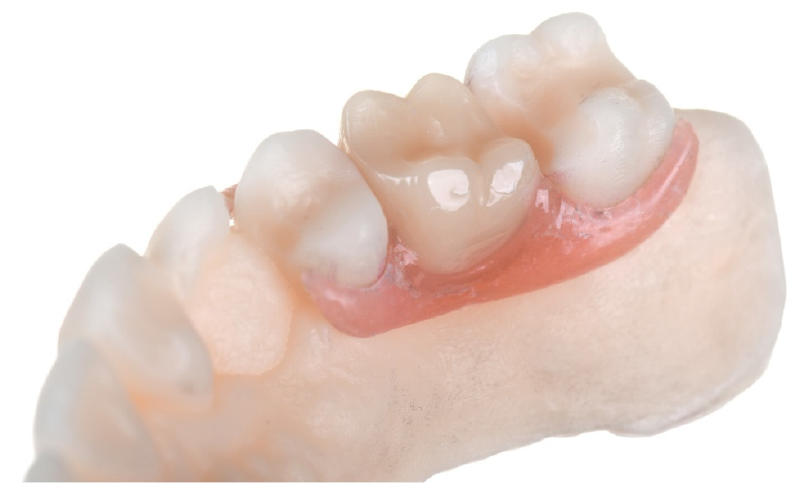
Figure 4. A: The finally adjusted and polished denture on the printed model.